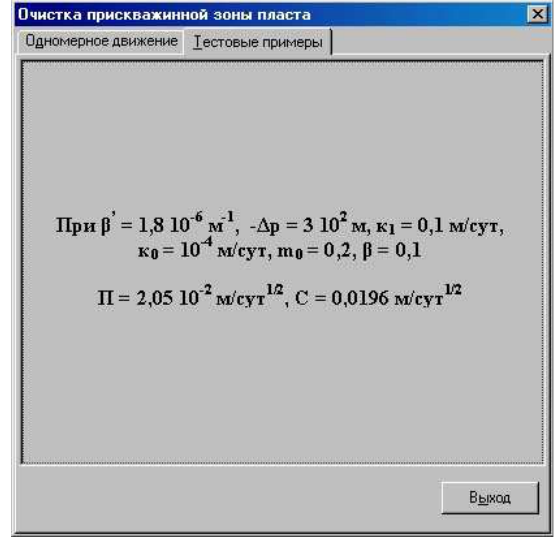
Figure 12: Baring of the well bore